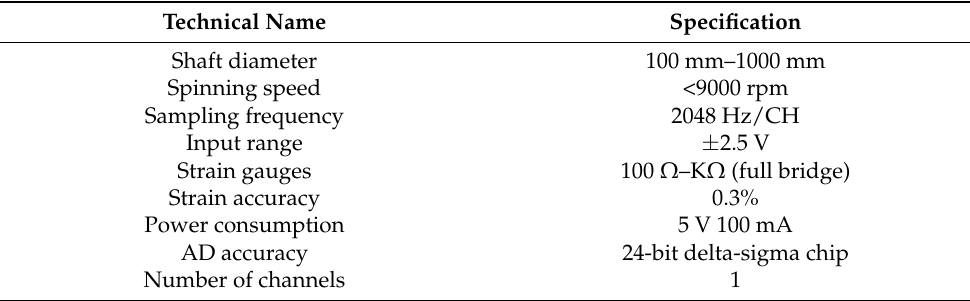
Figure 6. The wireless torque telemetry system. Table 3. Wireless torque telemetry system parameters.